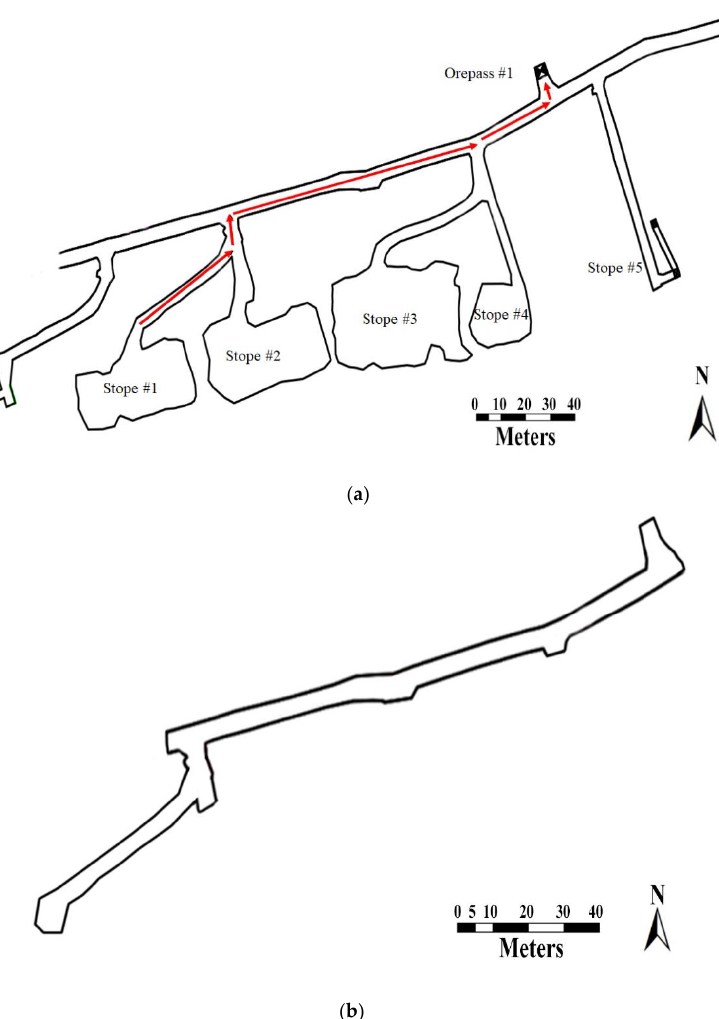
Figure 13. The map of the case study. ( a ) The original map; ( b ) the simplified map.